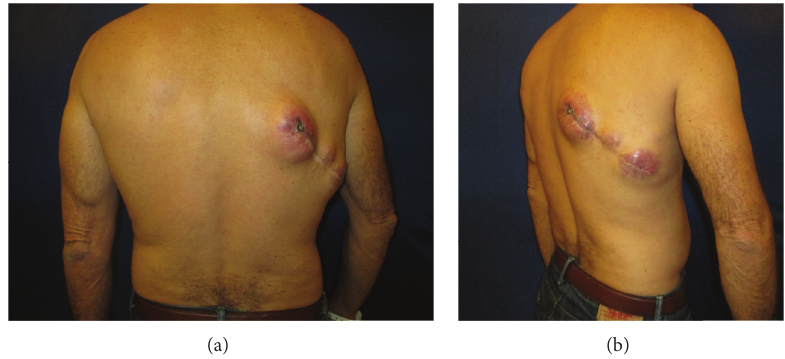
Figure 2: Preoperative assessment of recurrent malignant granular cell tumor at site of previous surgical